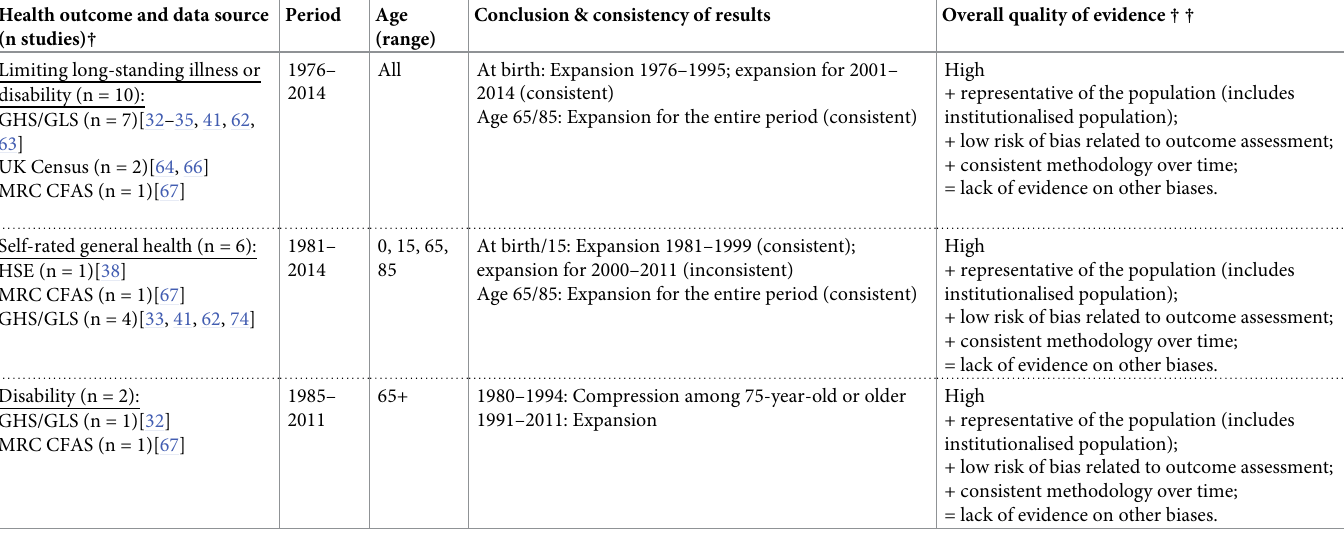
Table 8. The characteristics of evidence on health expectancy, with the emphasis on size, consistency and